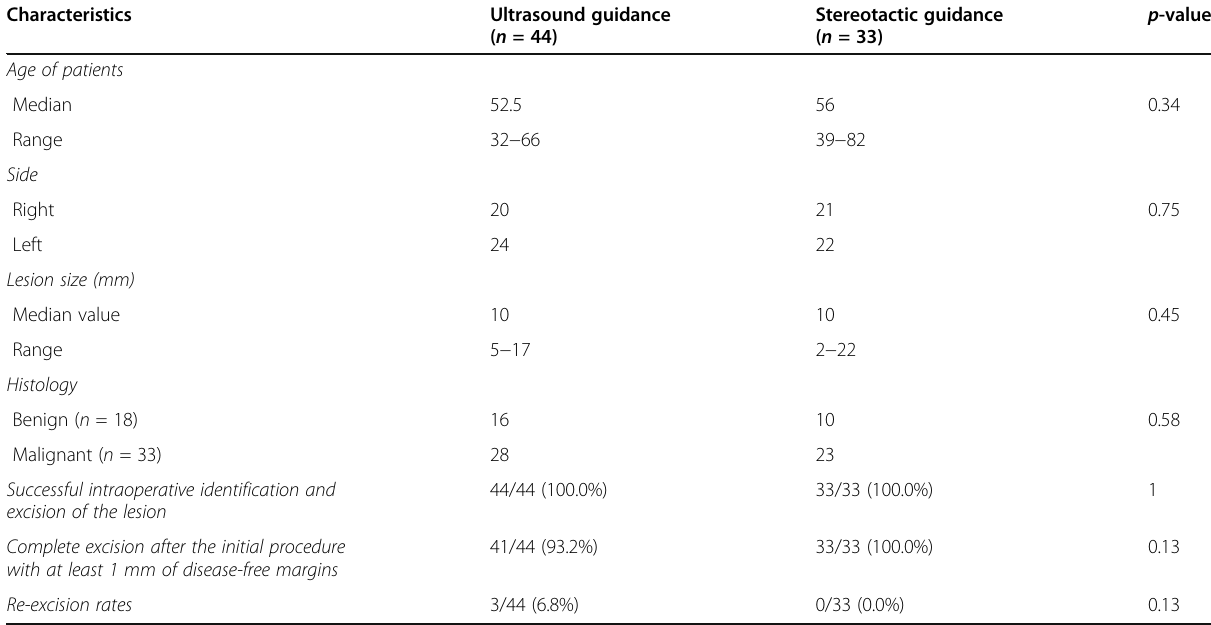
Table 1 Characteristics of patients ( n = 73) and breast lesions ( n = 77) and performance of Magseed® preoperative localisation according to ultrasound or stereotactic guidance